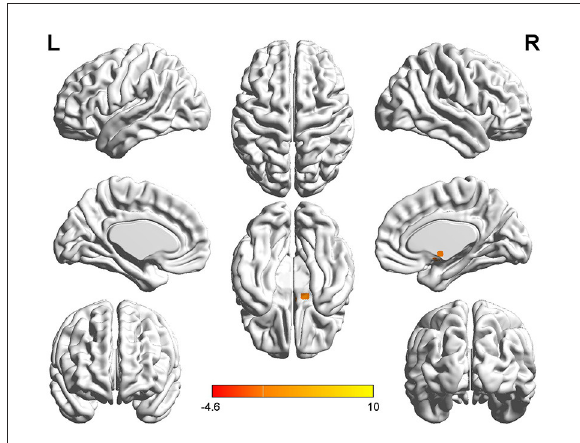
FIGURE2 T -value map of differential results of mALFF between right auditory neuroma and healthy controls. Compared with healthy controls, the value of mALFF in the right rectus gyrus of patients with right acoustic neuroma was increased, and there was no significant decrease in the brain regions. The statistical threshold was voxel-wise p < 0.001 with cluster-wise FWE corrected p < 0.05 (122